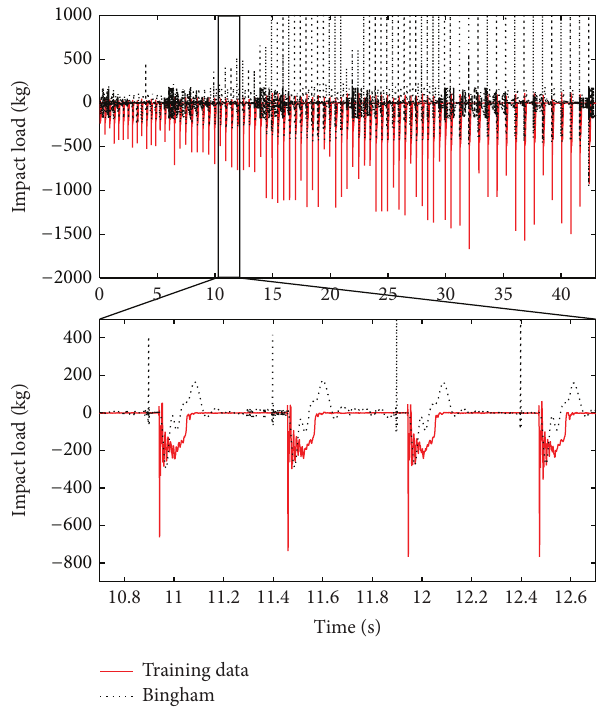
Figure 13: Comparison of the impact load measurements with Binghamplasticmodelforvariouscurrentsanddropreleaseheights.